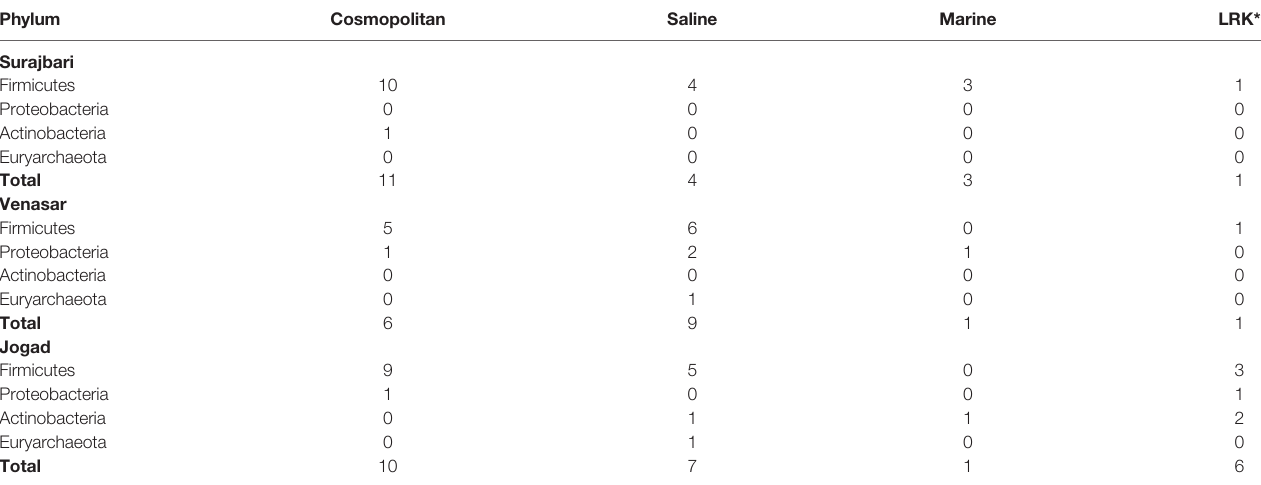
TABLE 4 | Geographical distribution pro fi le of phylotypes in three study sites. Phylum Cosmopolitan Saline